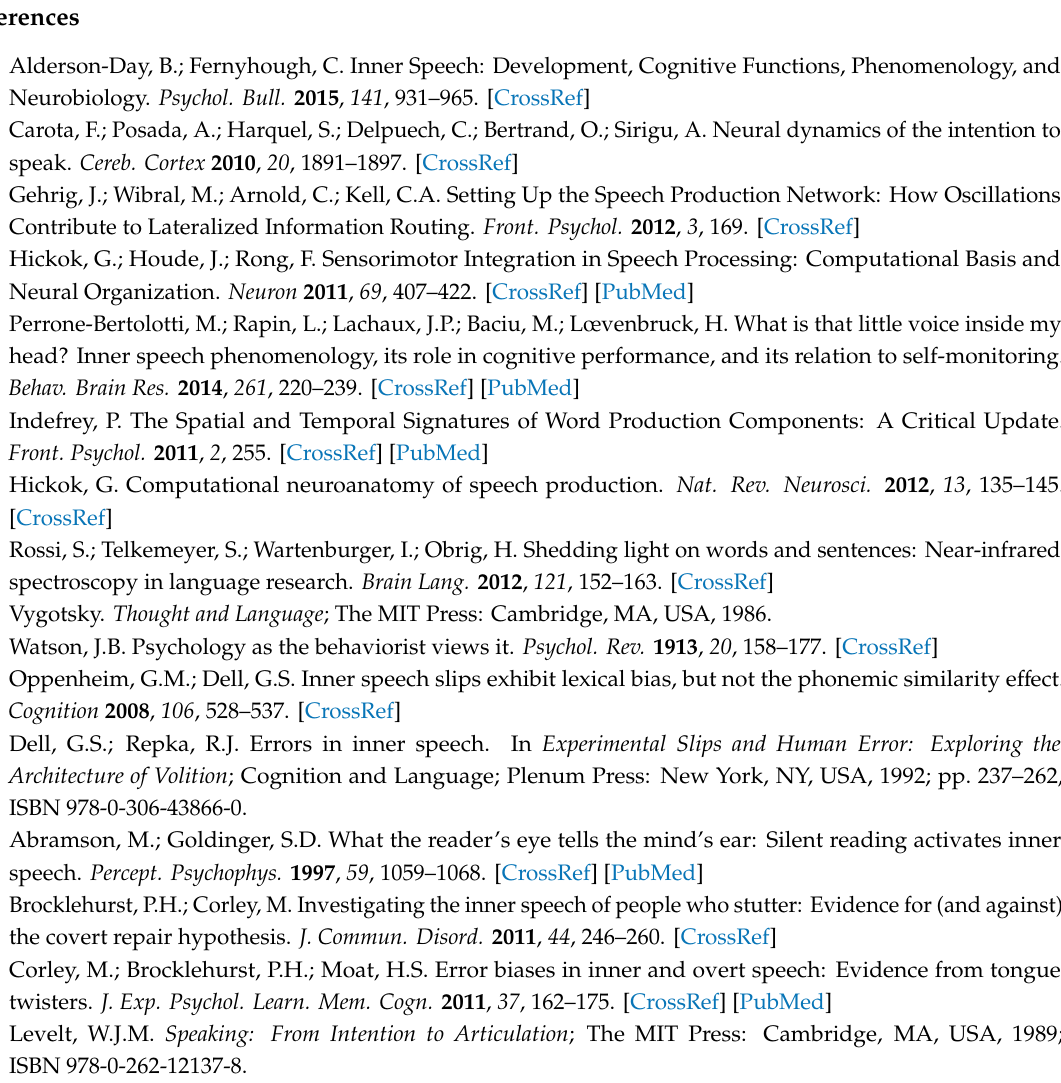
Table S1: EEG results of interactions of the repeated-measure ANOVAs (first column) and post-hoc testing in the time window of 200–300 ms. Table S2: EEG results of interactions of the repeated-measure ANOVAs and post-hoc testing in the time window of 300–500